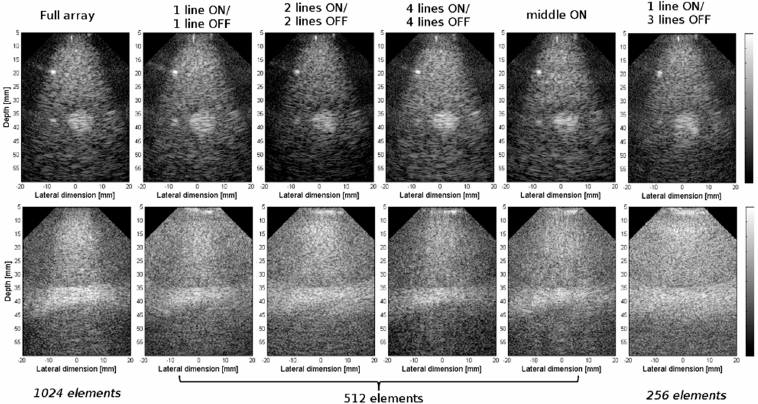
Figure 7. Experimental data acquired with 9 PW on a standard cyst phantom. Different configurations of the US array were used: full array, 1 line ON-1 line OFF, 2 lines ON-2 lines OFF, 4 lines ON-4 lines OFF, middle ON and 1 line ON-3 lines OFF. The shown planes, ( x , z ) (first row) and ( y , z ) (second row) are taken in the center of the US device. A dynamic of 50 dB has been used in all the images.